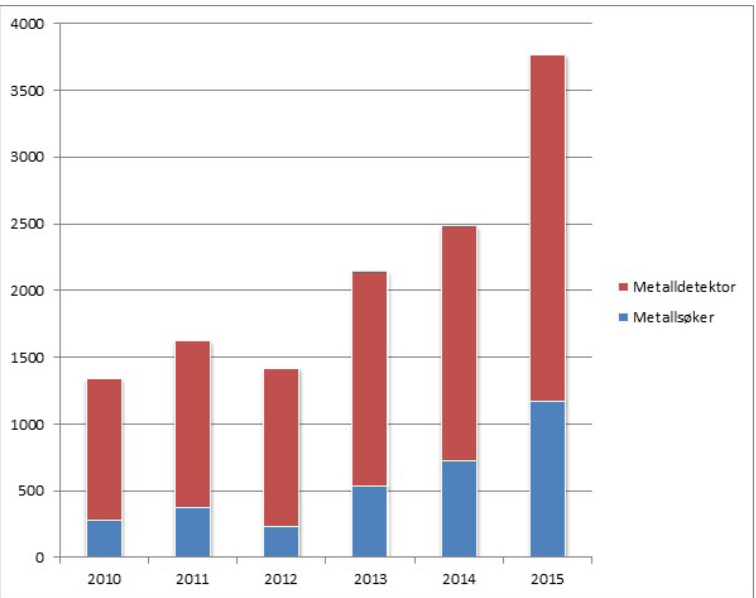
Figure 1. A Google search for the two most commonly used phrases for metal detector ( metallsøker/metalldetektor ) sorted by publication date (Norwegian sites, Norwegian language only) reflects increased interest in metal detecting in Norway the last few